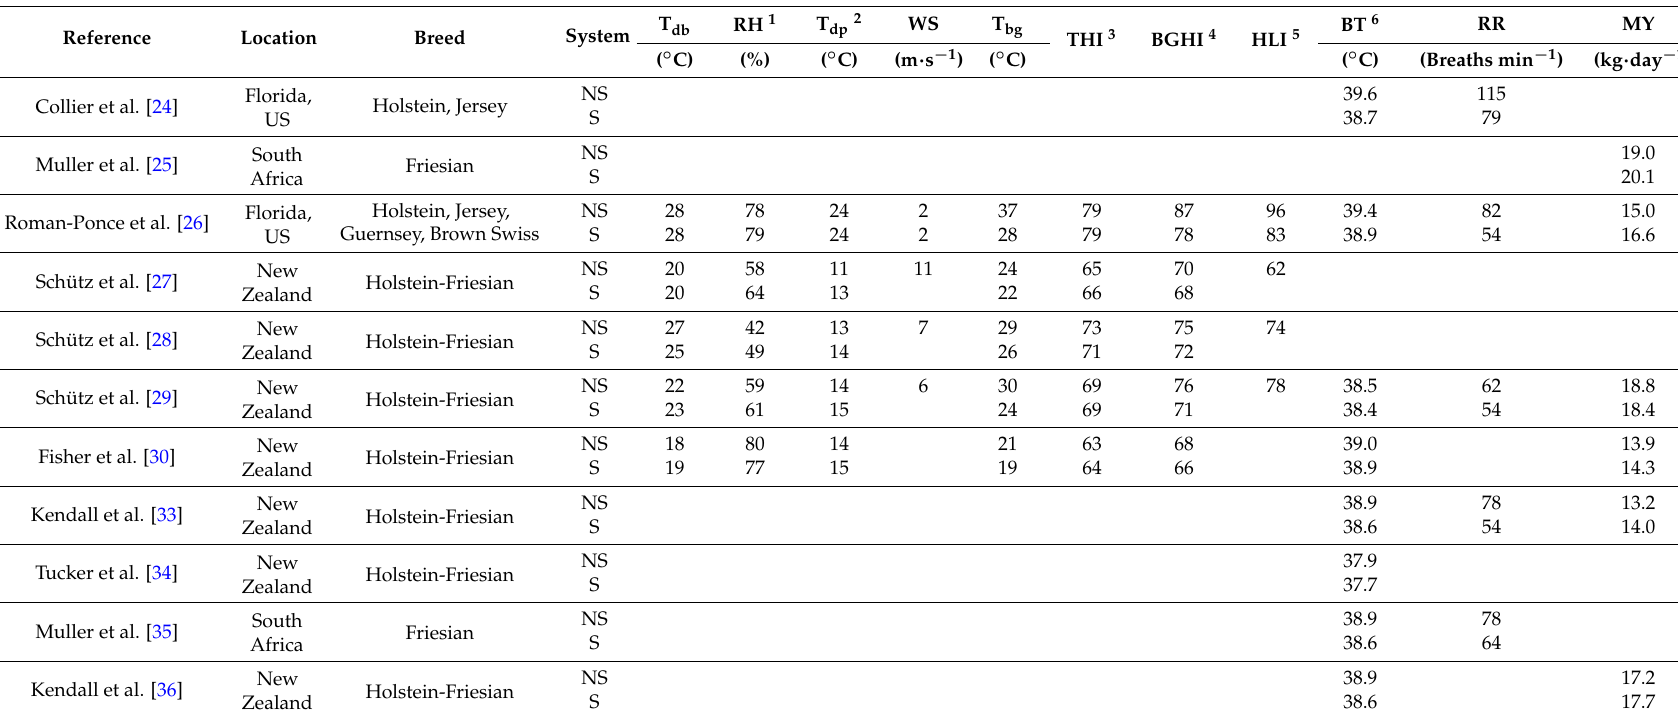
Table 1. Meteorological and thermal stress attributes and physiological response for non-shaded (NS) and shaded (S)